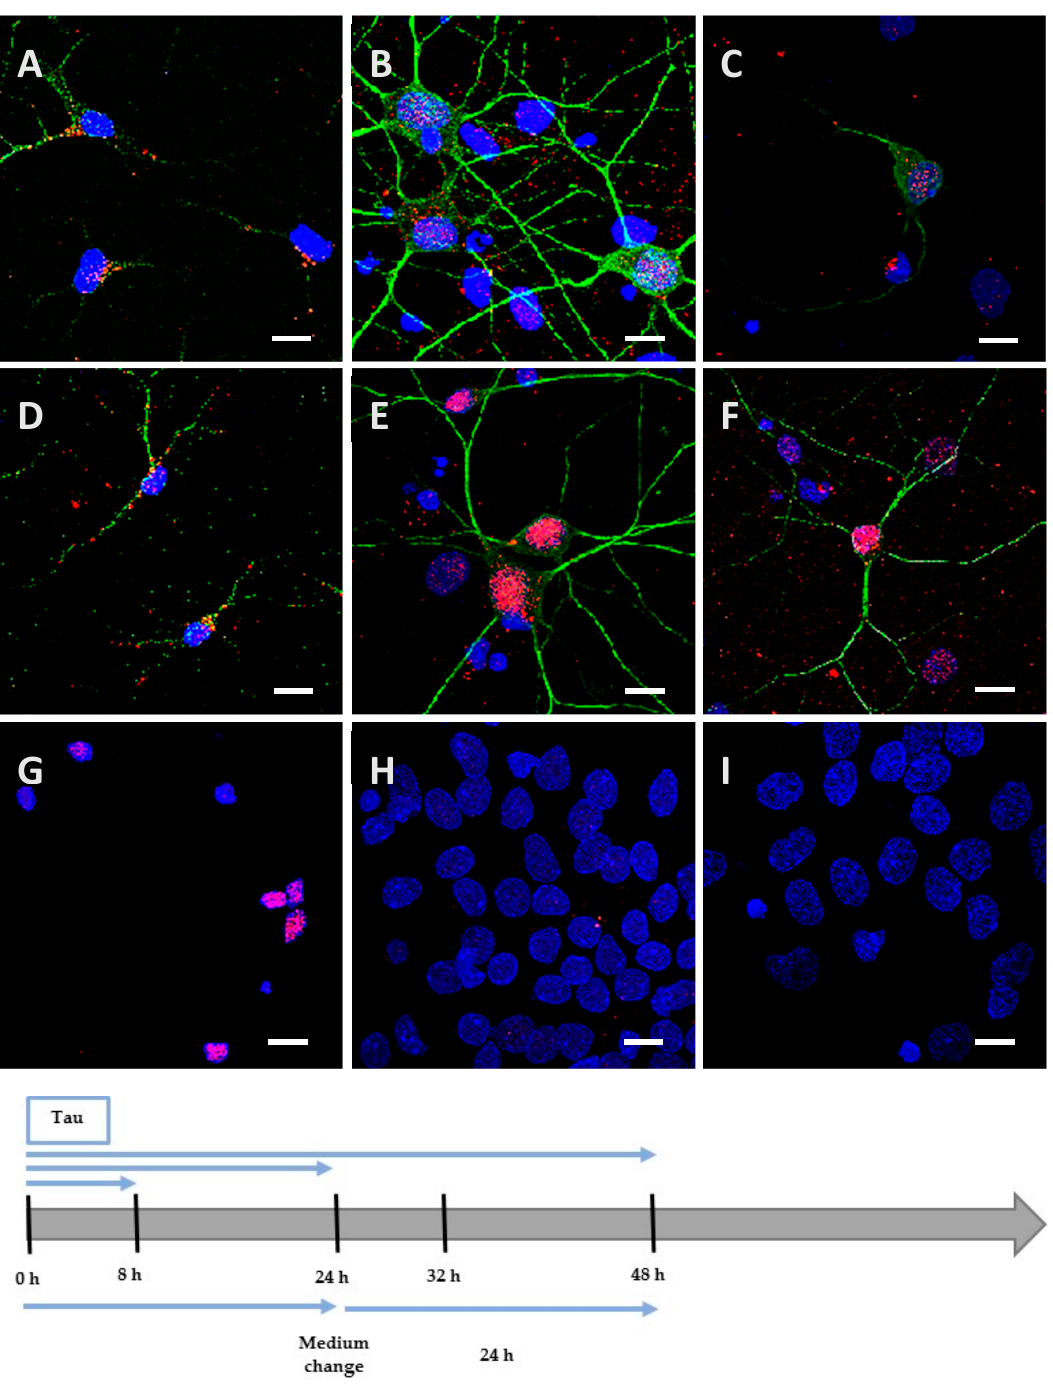
Figure 3. Internalization and processing of the Tau protein (15 μ g; A – C , H ) and its highly phosphorylated form (1.5 μ g; D – F , I ) by cortical cells. Following 8 h ( A , D ), 24 h ( B , E ), or 48 h ( C , F ) of incubation with protein, cells were immunostained with a mouse anti ‐ His ‐ tag antibody targeted by an AlexaFluor ® 594 antibody (red) and a rabbit anti ‐ MAP2 antibody targeted by an AlexaFluor ® 488 antibody (green). In other experiments, cells were placed in contact with protein for 24 h, whereupon the medium was replaced by one devoid of protein and maintained for an additional 24 h ( H , I ). The negative control ( G ) showed a non ‐ specific distribution of the anti ‐ His ‐ tag, localized only in the nucleus. Nuclei were stained with DAPI. The protein was sometimes detected outside cells where it was probably attached to the extracellular matrix. All scale bars correspond to 10 μ m.